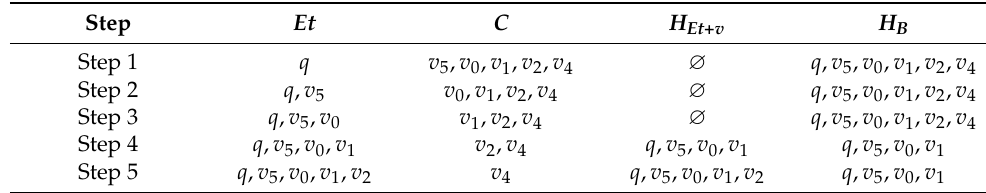
Table 2. Illustration of Algorithm 1 on the graph in Figure 1.